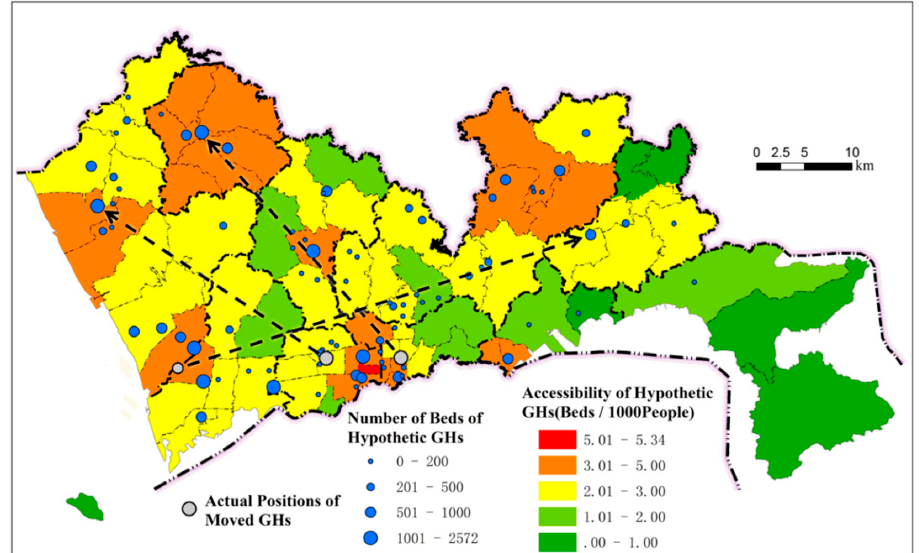
Figure 8. Spatial accessibility of hypothetic GHs.